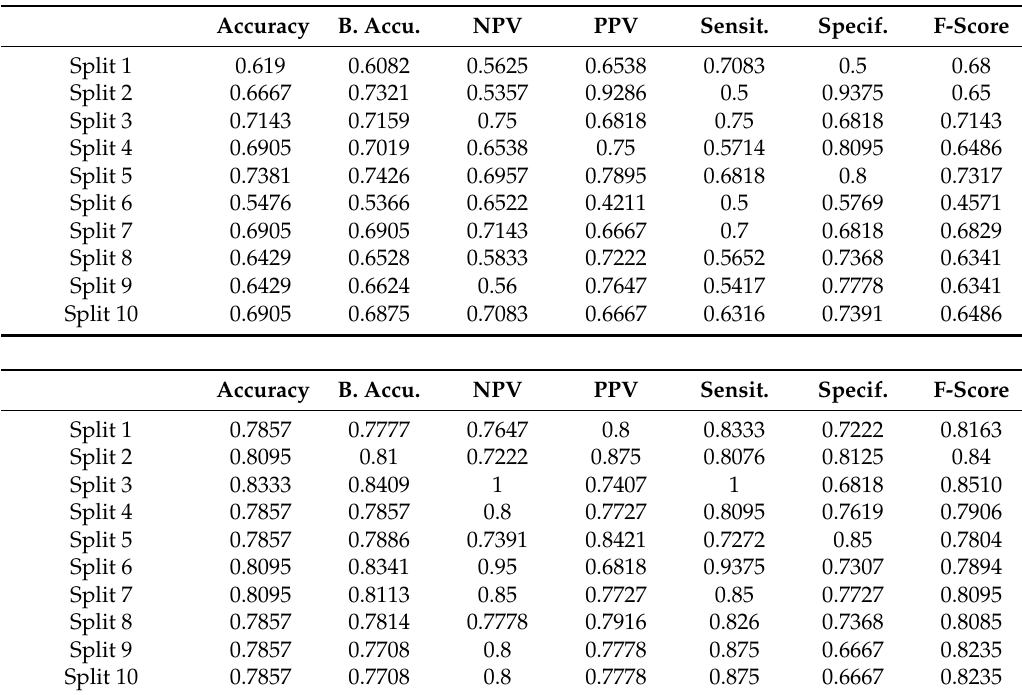
Table A3. Evaluation results showing a comparison between the evaluation metrics for each test split using the Clinica baseline ( upper table ) and the proposed method (SVM trained using a linear kernel) for the dataset of subjects aged 60 and over ( lower table